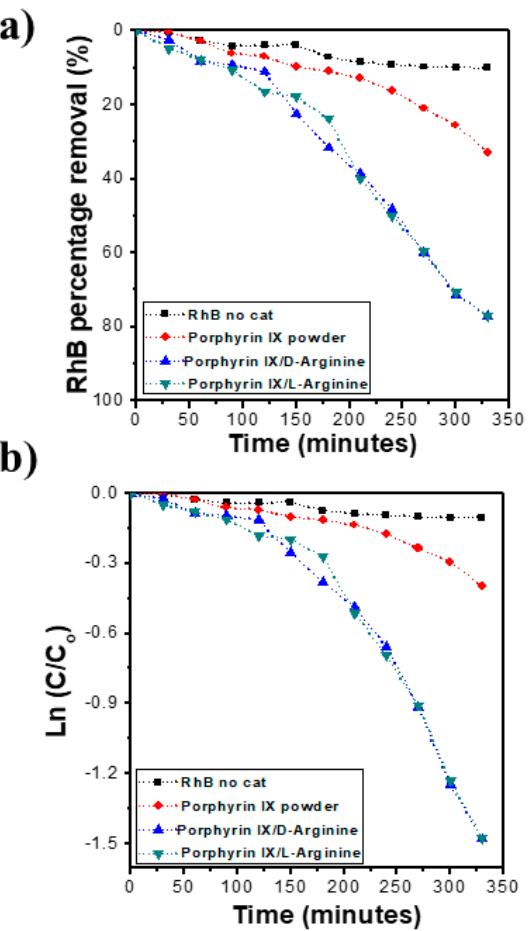
Figure 6. ( a ) Photocatalytic performance of rhodamine B (RhB) degradation and ( b ) the kinetic simulation curves.